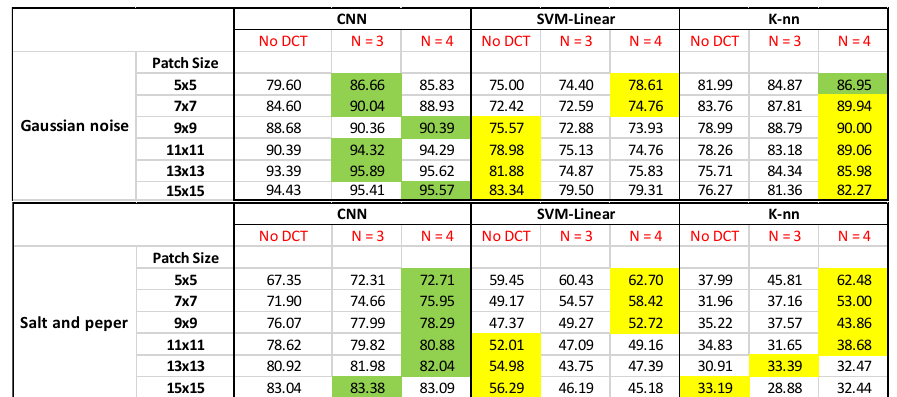
Figure 4: Pavia University Dataset: Classification accuracy rates for CNN, SVM and k-NN based approaches, for Gaussian and Salt & Pepper noise, for different patch sizes and different numbers of zeroed high- frequency DCT coefficients. Yellow-coloured rates show the best performing configuration per technique, and green-coloured rates the best performing one among all techniques for the given patch size.